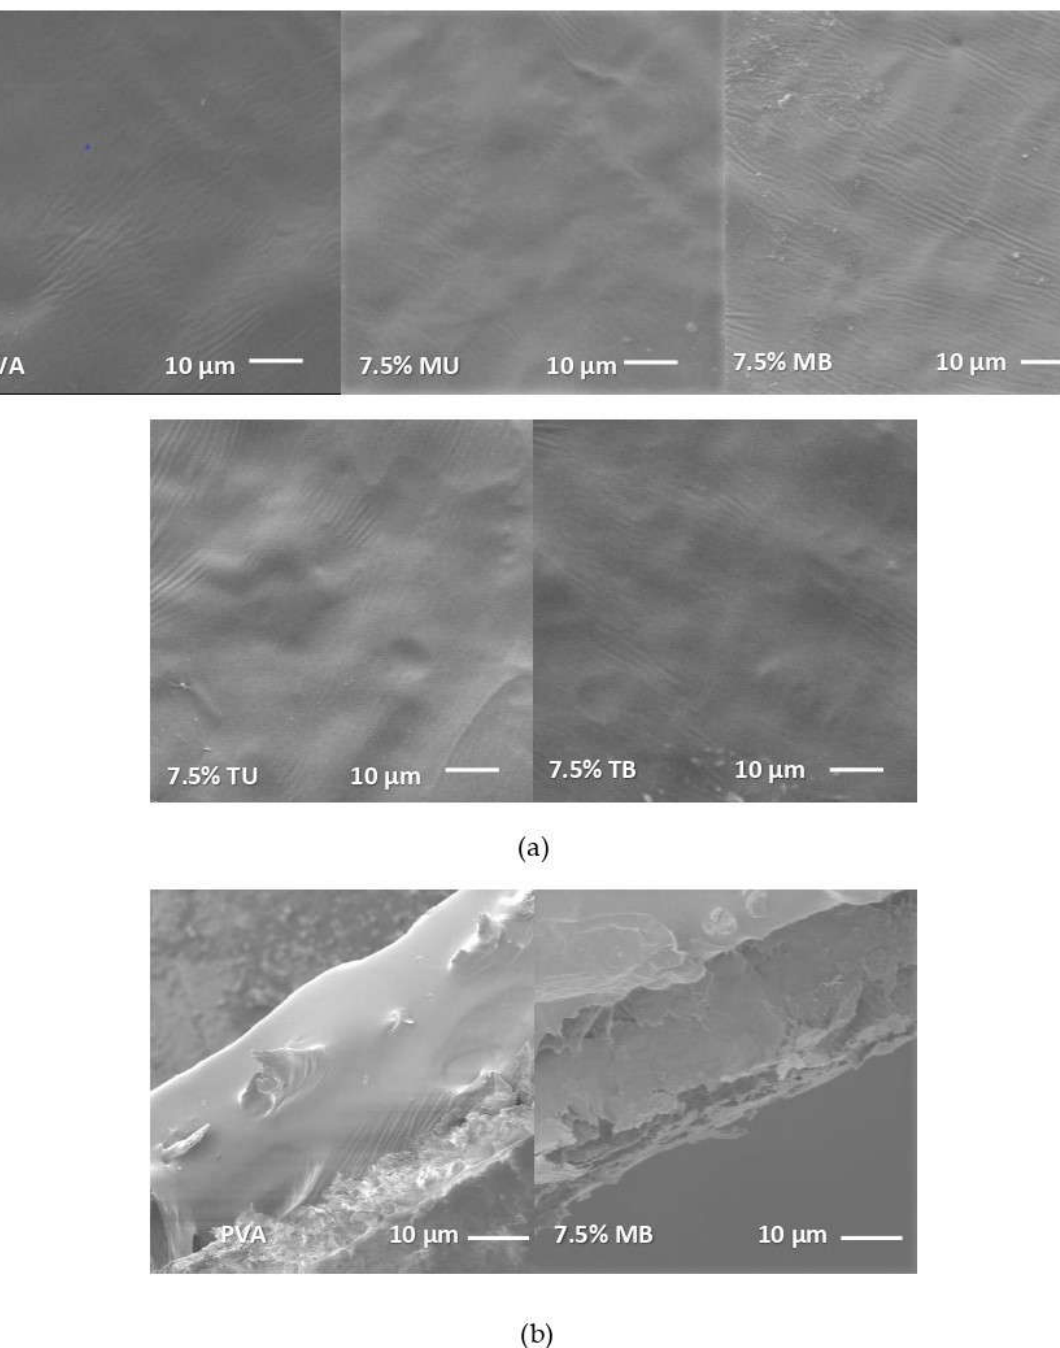
Figure 1. SEM micrographs of pure PVA and PVA-(L)CNF films. ( a ) surface of pure PVA, PVA containing 7.5% of mechanical unbleached nanocellulose (7.5% MU), PVA containing 7.5% of mechanical bleached nanocellulose (7.5% MB), PVA containing 7.5% of TEMPO unbleached nanocellulose (7.5% TU), PVA containing 7.5% of TEMPO bleached nanocellulose (7.5% TB); ( b ) cross-section of pure PVA and PVA containing 7.5% of mechanical bleached nanocellulose (7.5% MB).